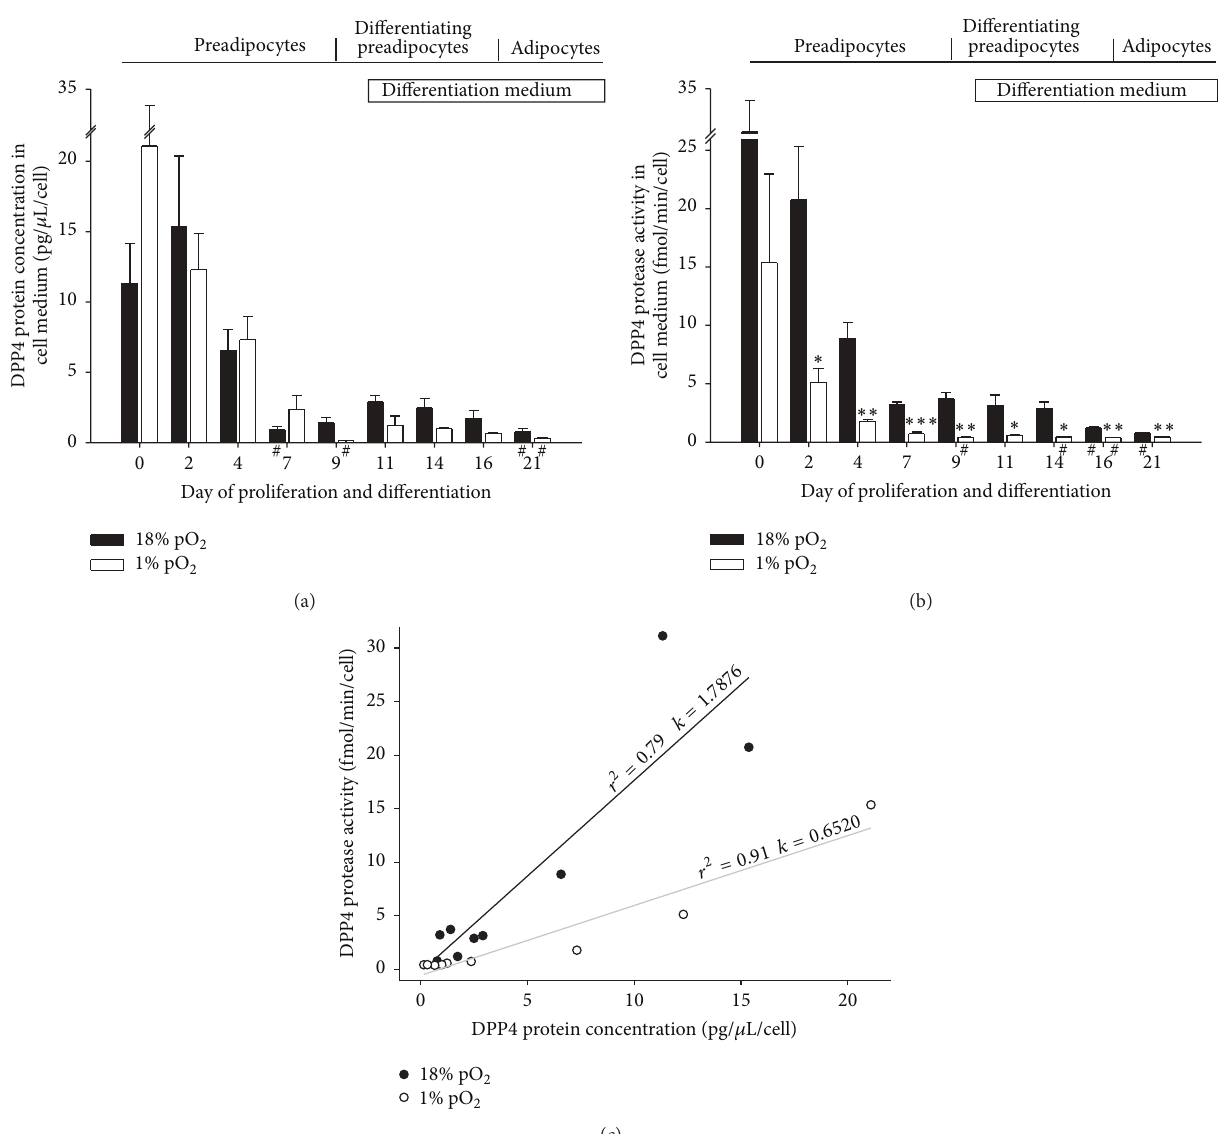
Figure 4: Differentiation and hypoxia reduce the shedding of DPP4 from human preadipocytes cultured in vitro . (a) Normalized DPP4 protein concentration in conditioned medium of cells at different stages of differentiation from preadipocytes to mature adipocytes cultured under normoxic (black bars) and hypoxic (white bars) environmental conditions. (b) Normalized DPP4 protease activity in conditioned medium of cells at different stages of differentiation from human preadipocytes to mature adipocytes cultured in normoxic (black bars) and hypoxic (white bars) environmental conditions. Data are normalized to the total cell number in the sample and presented as mean values ± SE. Asterisks above the white bars denote significant difference between hypoxic versus normoxic condition on the same differentiation day (Student’s 𝑡 -test; ∗ 𝑃 < 0.05 ; ∗∗ 𝑃 < 0.01 ; ∗∗∗ 𝑃 < 0.001 ); # under the bars denotes significant difference compared with day 0 for respective oxygenation condition (one-way ANOVA; # 𝑃 ≤ 0.01 ). (c) Correlation between the concentration of DPP4 in the conditioned media and its activity under normoxic (black dots) and hypoxic (open dots) conditions ( 𝑘 , slope coefficient; 𝑟 2 , correlation coefficient). The equation of regression lines is as follows: DPP4 activity [fmol/min/cell] = ( 1.79±0.35 ) × DPP4 concentration [pg/ 𝜇 L/cell] − ( 0.2±2.4 ) [fmol/min/cell] for the correlation in normoxia and DPP4 activity [fmol/min/cell] = ( 0.65±0.08 ) × DPP4 concentration [pg/ 𝜇 L/cell] − ( 0.6±0.7 )[fmol/min/cell] for the correlation in hypoxia. The slopes are significantly different ( 𝑃 < 0.001 ), whereas the intercepts are similar and not different from